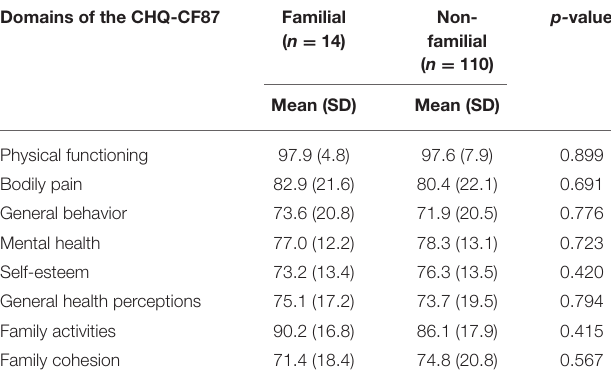
TABLE 4 | Generic quality of life in adult patients with Hirschsprung’s disease of the rectosigmoid. Domains/Facets of the